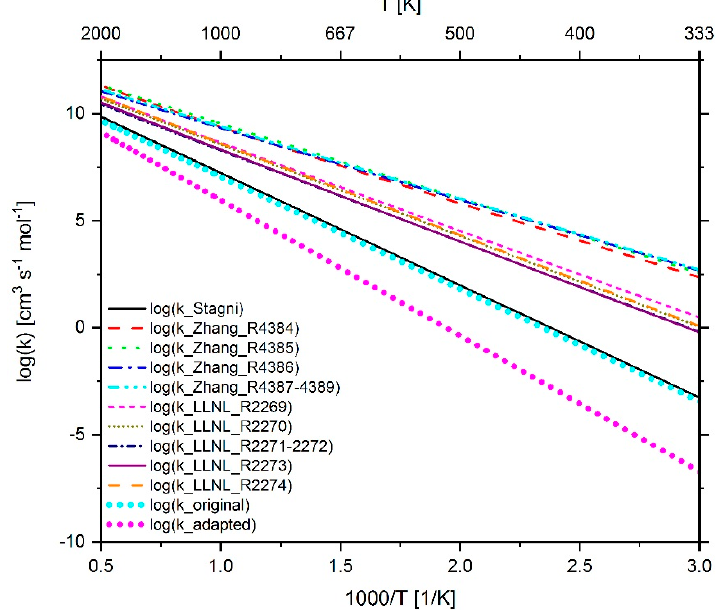
Figure 27. Comparison of the reaction rate coefficient of reaction 298 ( n -C 7 -QOOH ↔ HO 2 + C 7 H 14 ) before and after adaptation as well as the rate coefficient used in the mechanism of Stagni et al. [119], LLNL [23] and Zhang et. al . [21].